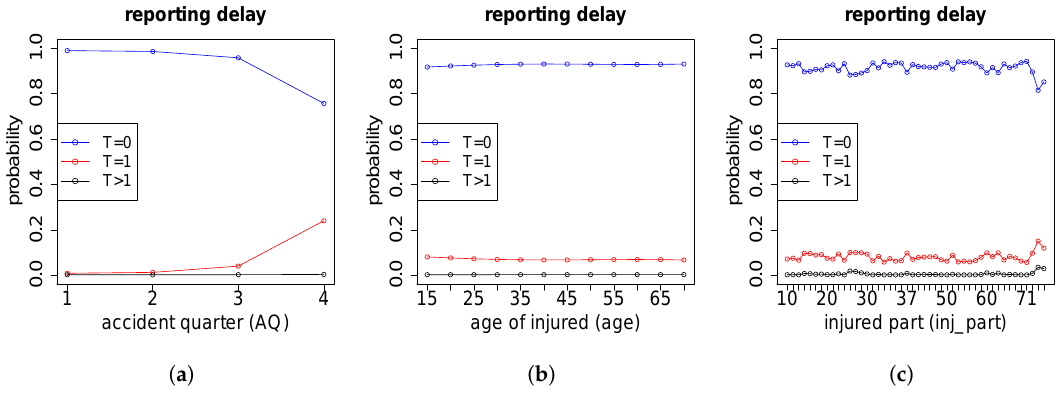
Figure A5. Reporting delay T w.r.t. the features ( a ) AQ ; ( b ) age and ( c ) inj_part .